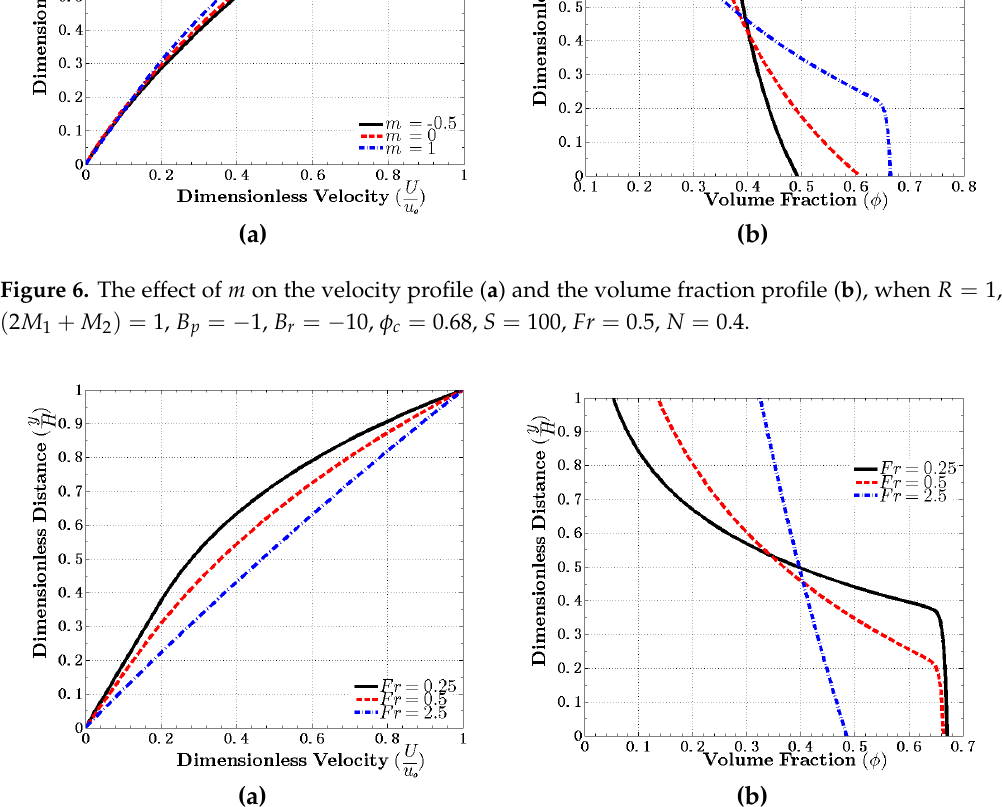
Figure 6. The effect of 𝑚 on the velocity profile ( a ) and the volume fraction profile ( b ), when 𝑅 = 1 , (2𝑀 (cid:2869) + 𝑀 (cid:2870) ) = 1 , 𝐵 (cid:3043) = −1 , 𝐵 (cid:3045) = −10 , 𝜙 (cid:3030) = 0.68 , 𝑆 = 100 , 𝐹𝑟 = 0.5 , 𝑁 = 0.4 .